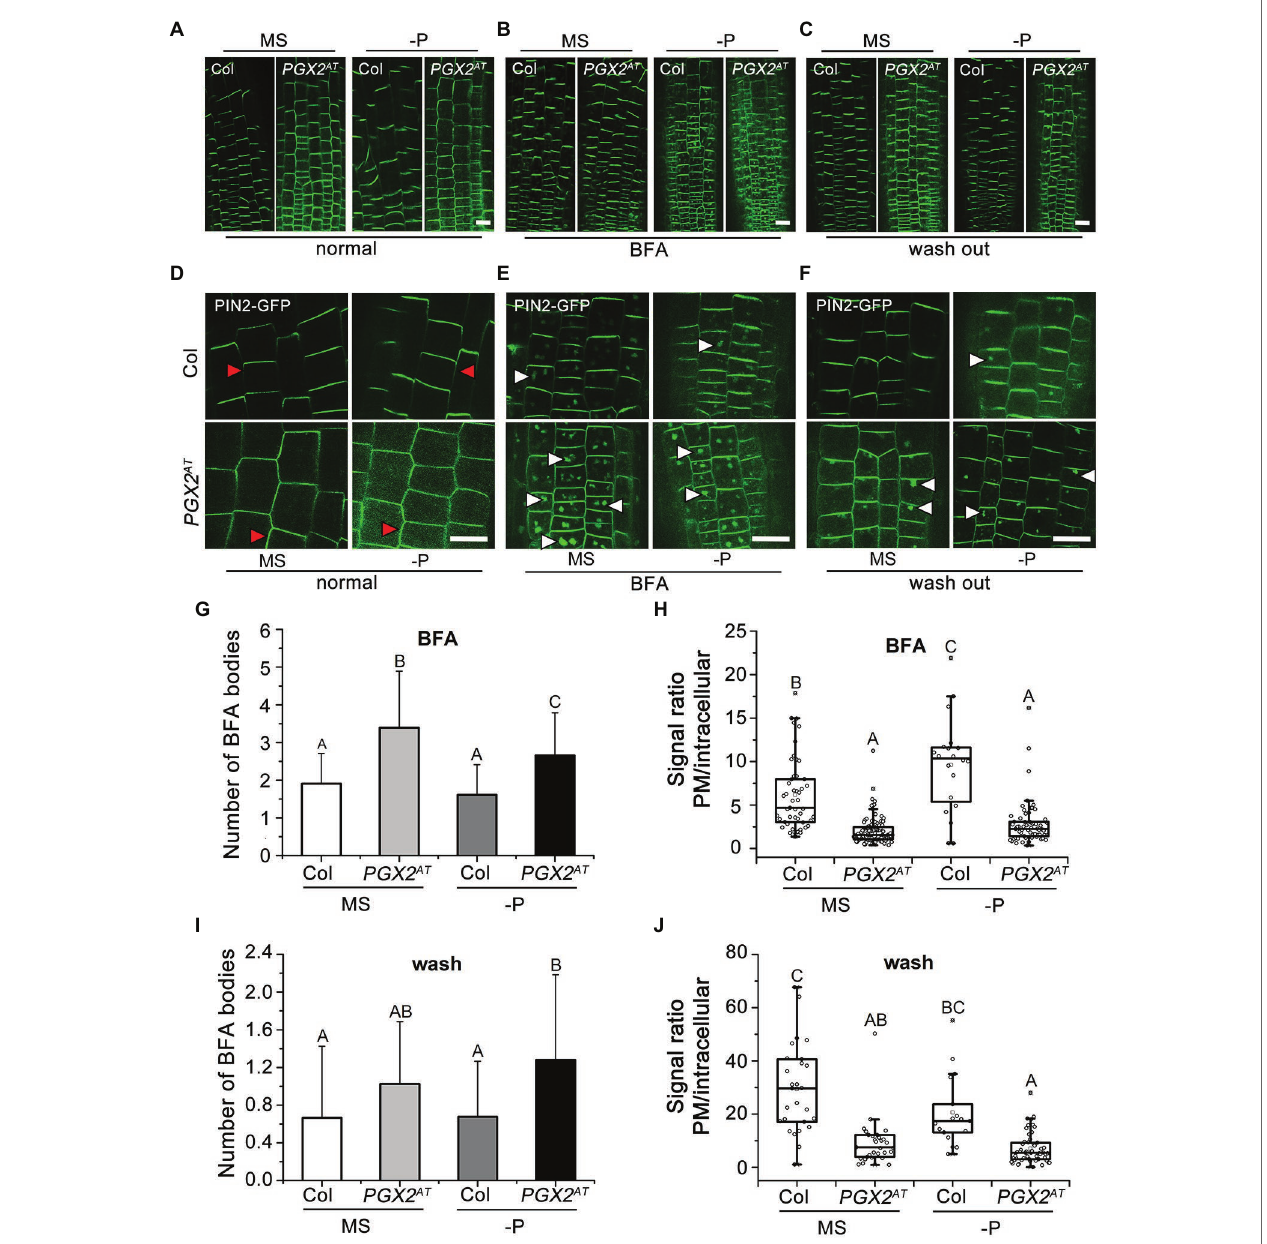
FIGURE 5 | The abundance of plasma membrane (PM)-localized PIN2 protein is reduced in PGX2 AT seedlings. (A–C) PIN2-GFP patterns in transgenic plants of PIN2-GFP Col and PIN2-GFP PGX2 AT seedling roots. PIN2-GFP images were taken after transferring for 4 days in those seedlings before (A) and after (B) BFA treatment for 30 min, and after BFA was washed out for 90 min (C) . Bars = 50 μ m. (D–F) Images recorded with higher magnification under a confocal microscope. Red arrowheads indicate plasma membrane-localized PIN2-GFP; white arrowheads indicate intercellular PIN2-GFP. Bars = 50 μ m. (G,H) Numbers of BFA bodies and signal ratio of PM to intracellular PIN2-GFP with BFA treatments ( n ≥ 50 cells from at least 10 seedlings). (I,J) Numbers of BFA bodies and signal ratio of PM to intracellular PIN2-GFP after washing BFA ( n ≥ 28 cells from at least 10 seedlings). Uppercase letters indicate significantly different groups as determined by one-way ANOVA with post-hoc Duncan’s test ( p <